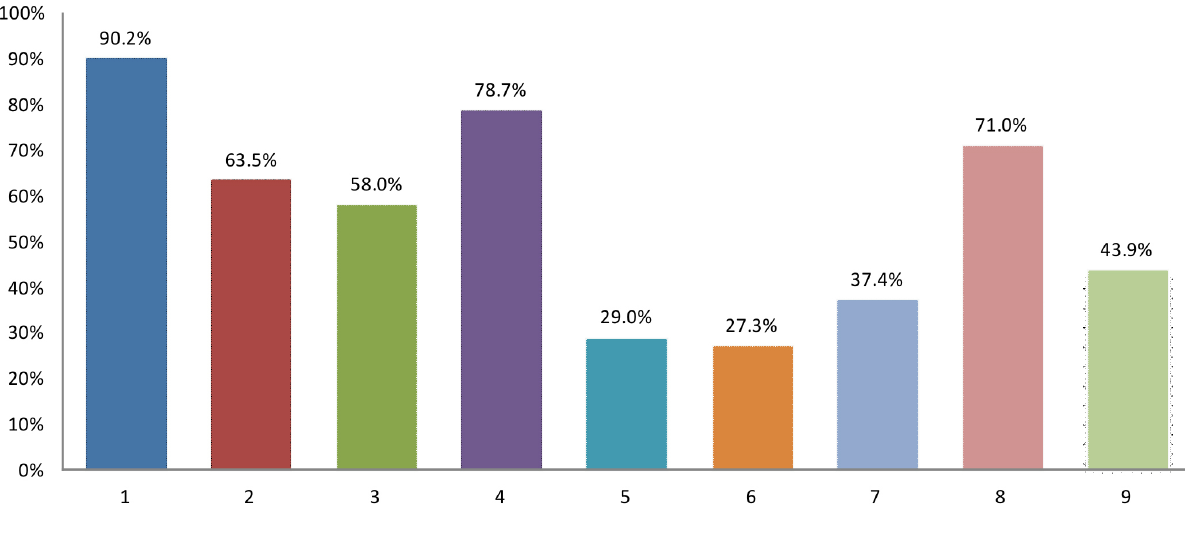
Figure 3. Key functions included by the computerized system. x-axis: 1=Electronic patient registration system; 2=Appointment booking system (e.g. arrangement of next patient visit); 3=Electronic clinical notes (eg, recording of patient history); 4=Dispensing system (eg, printing of prescriptions); 5=Order Entry functions (eg, laboratory, radiological exam order); 6=Picture Archiving and Communication System (PACS); 7=Electronic Health Care Voucher System (eHS); 8=Electronic Drug labels; 9=Public Private Interface-electronic Patient Record